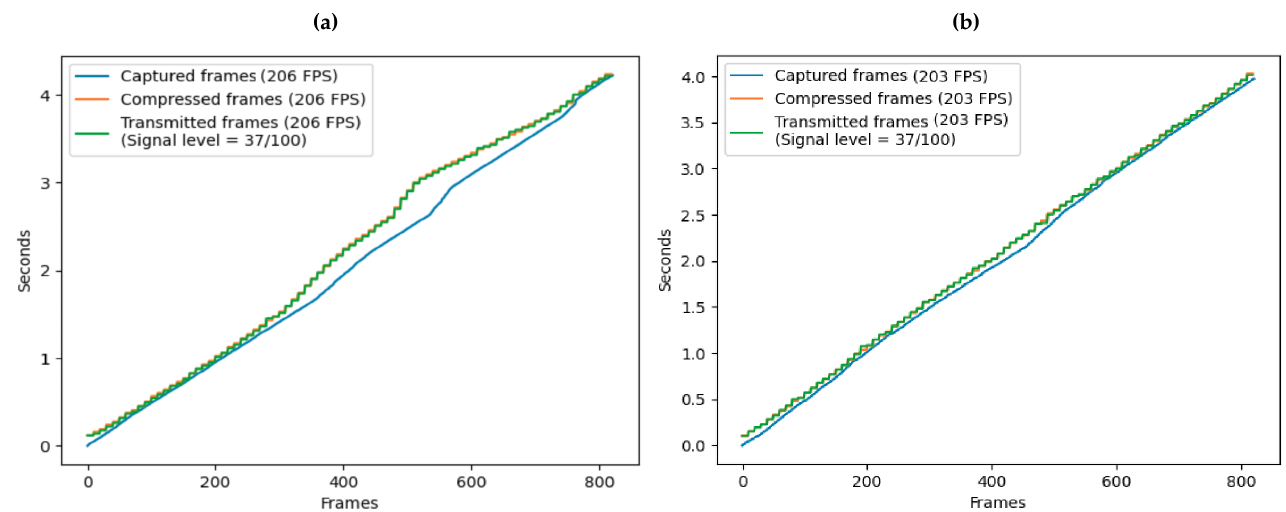
Figure 8. Graphical representation of the time in which each hyperspectral frame is captured, compressed and transmitted for the experiments displayed in Table 7. ( a ) uint12-bil version. ( b ) uint16-bip